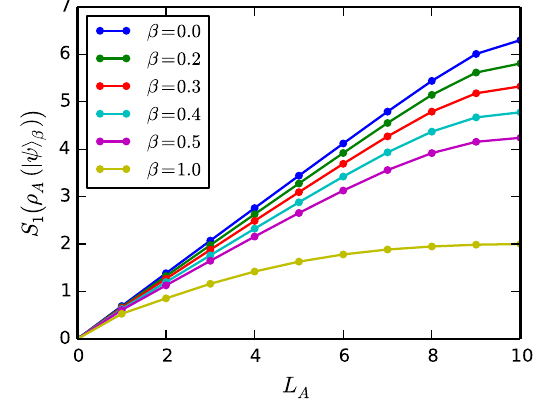
FIG. 3. Scaling of the von Neumann entanglement entropy S 1 with subsystem size for the L ¼ 20 system given in Eq. (30). Up to β ¼ 0 . 5 , the scaling is linear for small L , suggesting that the A states obey a volume law and are thus likely to satisfy ETH. The β ¼ 1 . 0 eigenstate, on the other hand, is clearly not linear, and it is too close to the ground state at this system size to exhibit